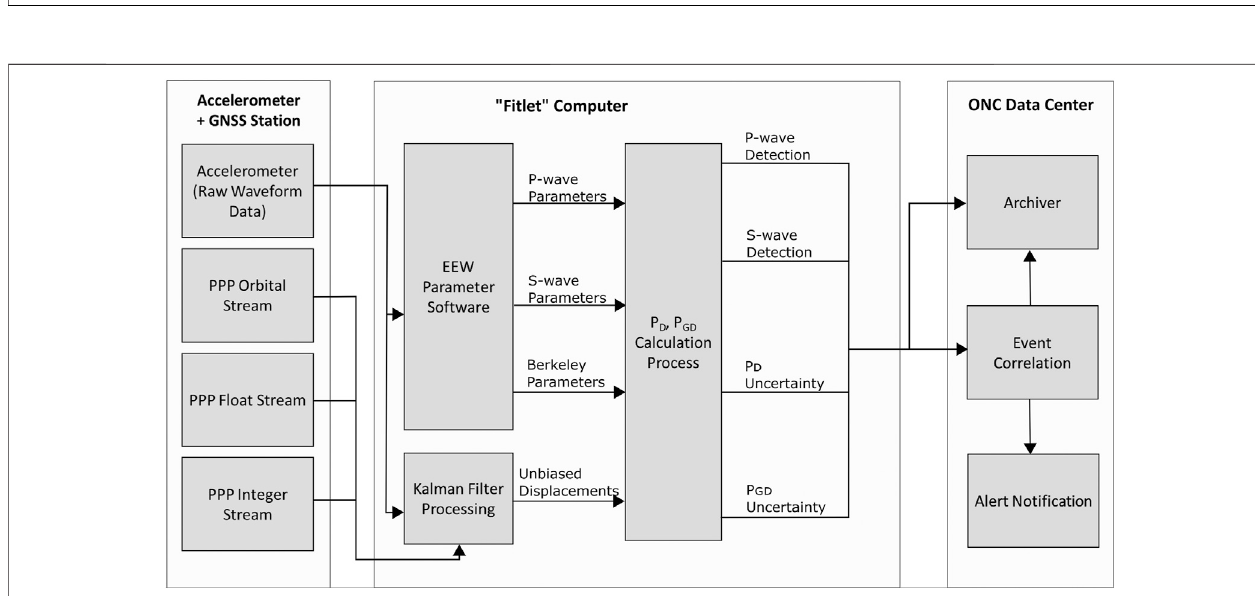
FIGURE 4 | Schematic overview of data fl ow from one land-based site to the event association in ONC ’ s data centre. The raw acceleration data are processed to obtain the detection times of P-wave and S-wave onsets and the seismically derived Berkeley parameters. The raw acceleration data and the data from the three PPP streamsarecombinedintheKalmanFilteralgorithmtoobtainunbiaseddisplacementvalues.TheseunbiaseddisplacementsarecorrelatedwiththeBerkeleyparameter values and the P-wave and S-wave detection times to compute an epicenter and magnitude estimate for the detected event. Parameter data from all sites that detected an event are sent to ONC ’ s data center where the event is associated, archived, and event noti fi cations are sent out.